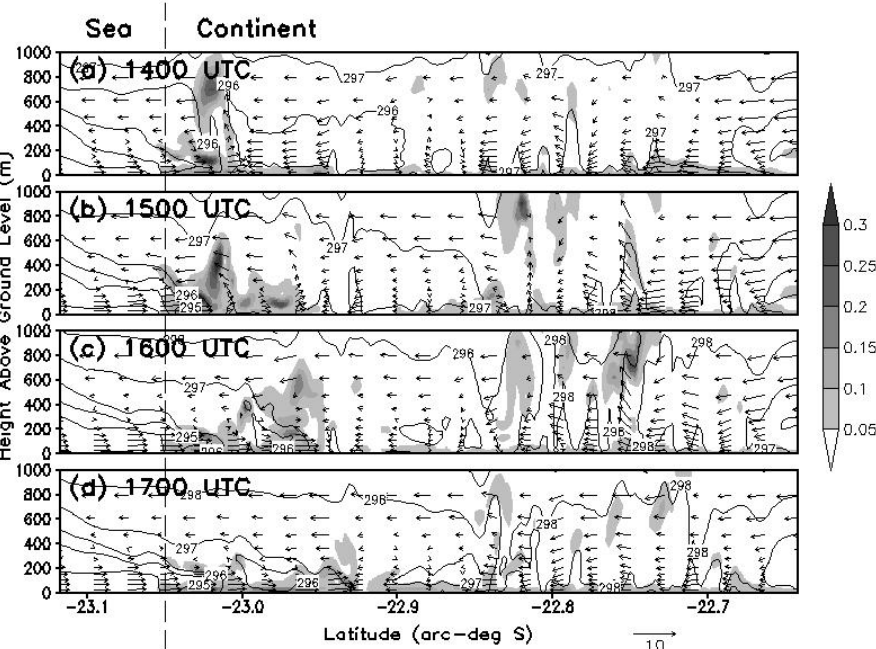
Figure 16. Vertical-latitudinal cross section of TKE (m 2 s − 2 – shaded areas), potential temperature (K – solid line) and meridional-vertical wind vector components (ms − 1 – vectors) up to 1.0kma.g.l. at − 43.60arc-deg west longitude (Marambaia longitude location). Values calculated on G5 for the HR run at (a) 14:00, (b) 15:00, (c) 16:00 and (d) 17:00UTC, 7 September